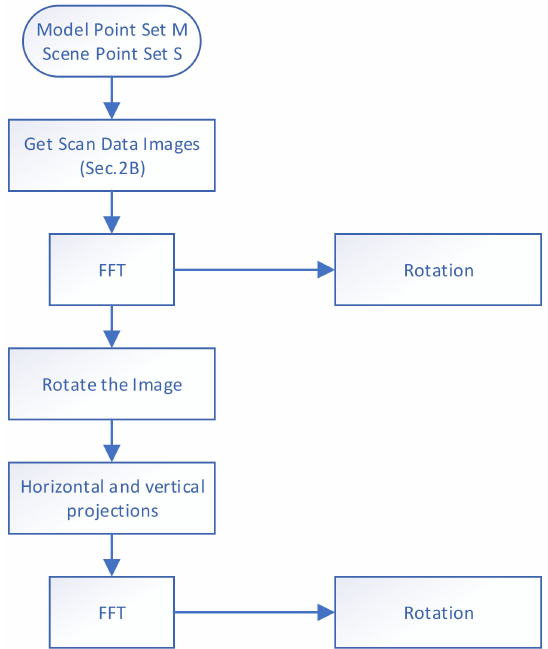
Figure 4. Fast Fourier Transform (FFT)-based